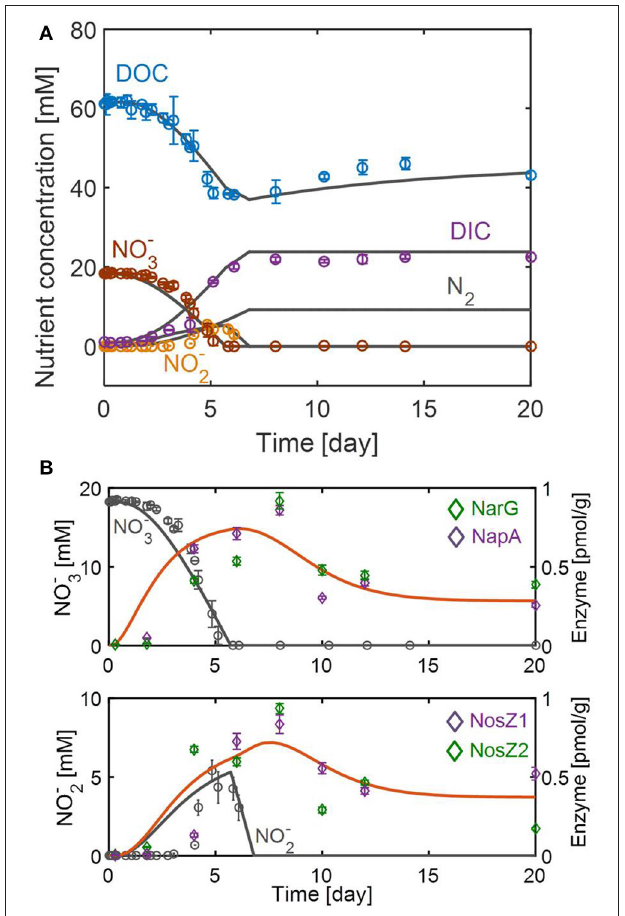
FIGURE 3 | Model fits and predictions of the dynamic changes in (A) substrates and (B) enzymes associated with NO − 3 reduction to NO − 2 (top) and the subsequent NO − 2 reduction to N 2 (bottom). Symbols in (A,B) represent the average concentrations of nutrients (DOC, DIC, NO − 3 , and NO − 2 ) and enzymes (NarG, NapA, NosZ1, and NosZ2) obtained from three and two biological replicates, respectively. Error bars denote the standard deviations of each measurement.